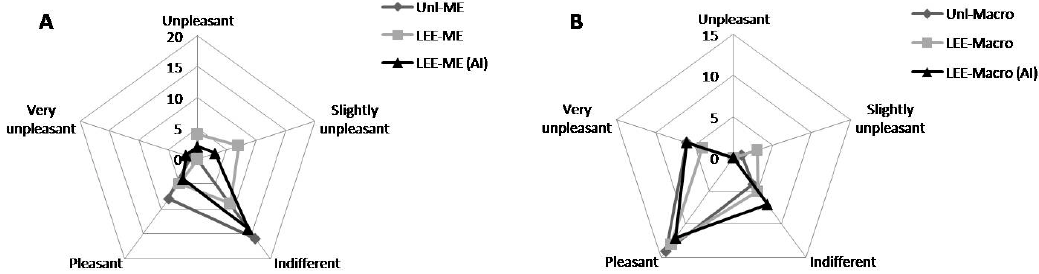
Figure 6. Sensorial analysis of the color in ME ( A ) and macroemulsions ( B ) evaluated by the 25 untrained volunteers.